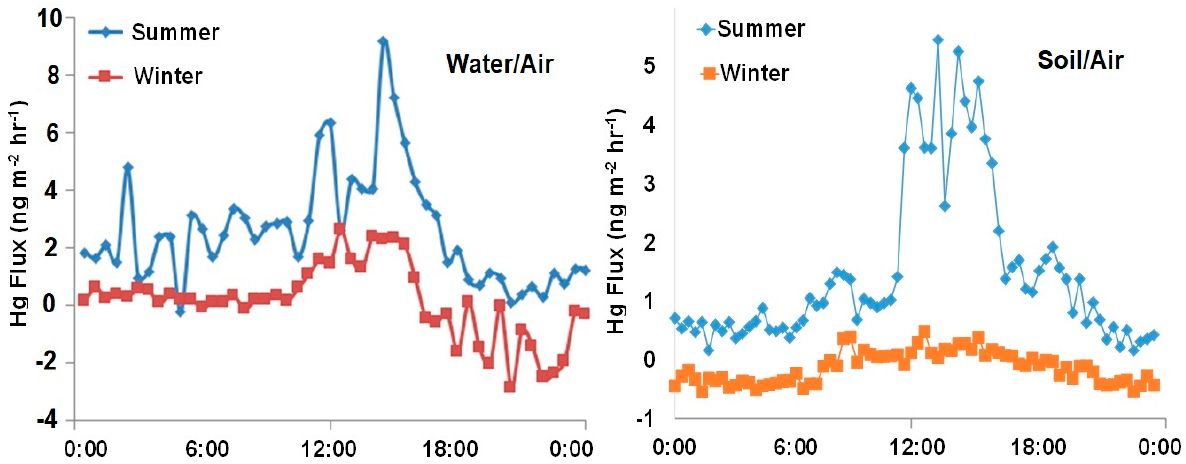
Figure 5. Examples of seasonal differences for gaseous elemental mercury (GEM) fluxes over the course of a day. Pond water/air fluxes ( left ) and agricultural soil/air fluxes ( right ).